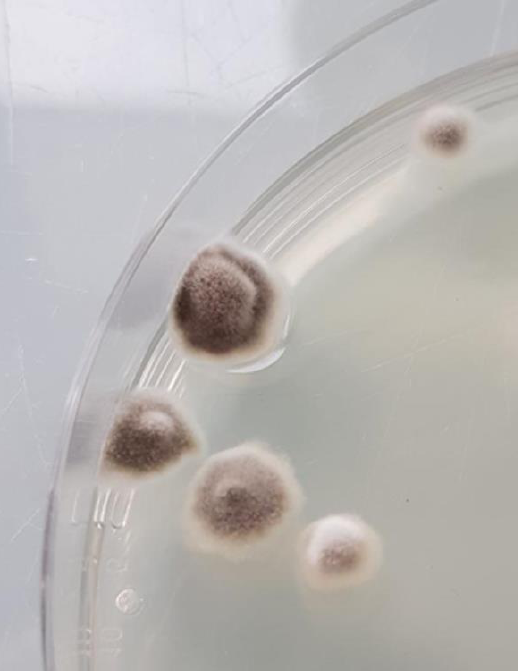
Figure 2. Olivaceous grey and floccose colonies of M. romeroi after three days of incubation at 28 °C on Sabouraud Dextrose Agar.